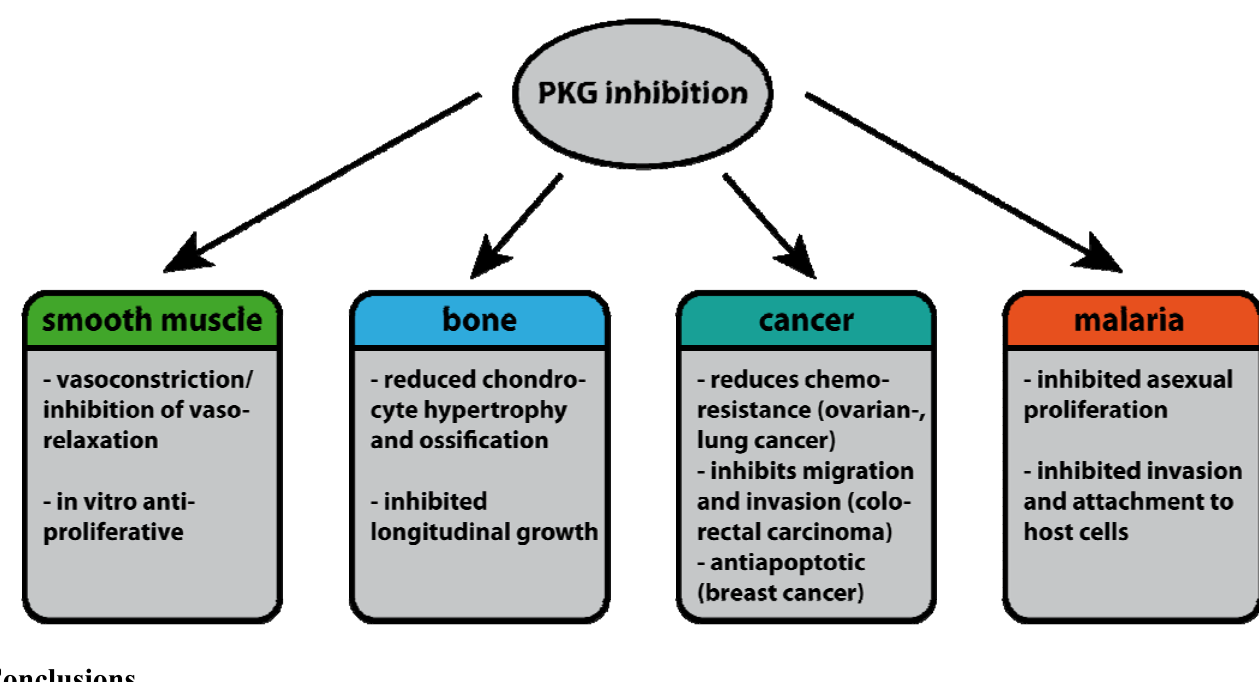
Figure 8. Effects of PKG inhibition on various